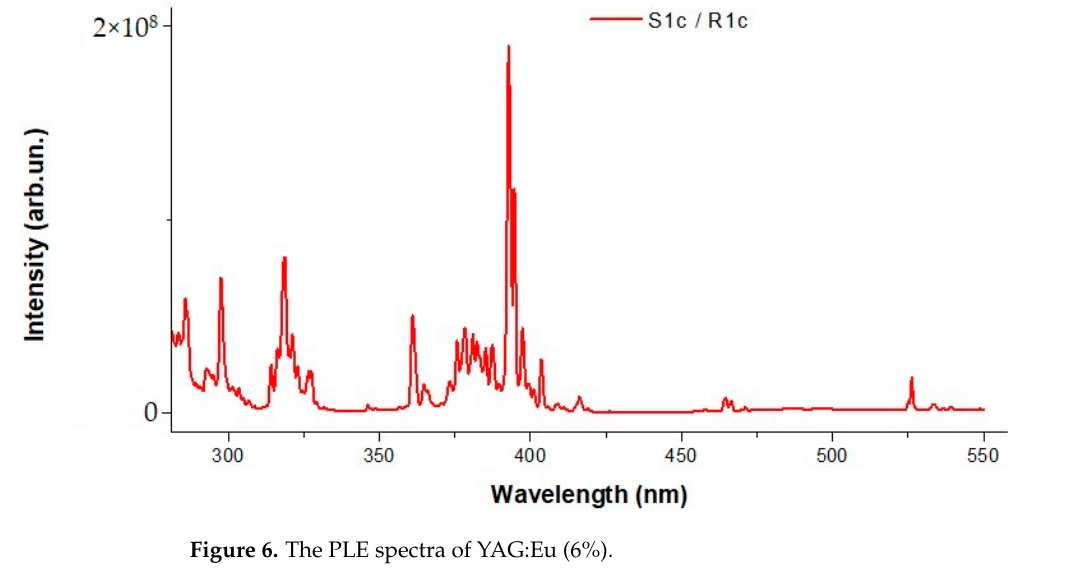
Figure 6. The PLE spectra of YAG:Eu (6%).